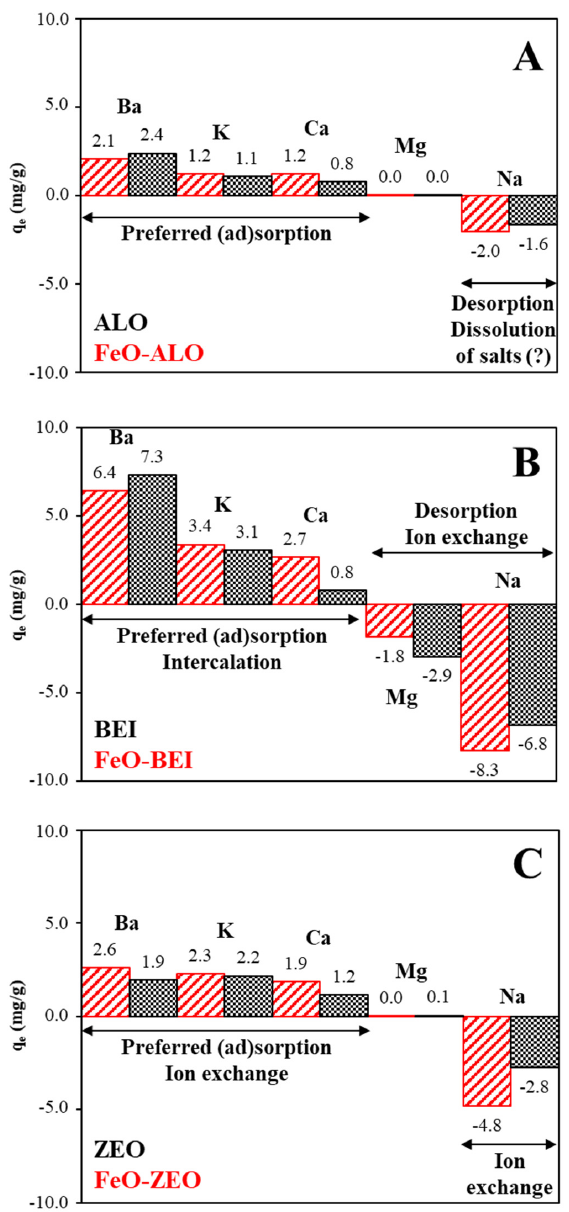
Figure 8. Effect of competing ions (operational conditions: 298 K, pH 6.0, adsorbate/adsorbent ratio: 500:1, cations: 0.85 mmol/L Ca 2+ , 0.20 mmol/L Mg 2+ , 163.2 mol/L Na + , 0.38 mmol/L K + and 0.30 mmol/L Ba 2+ ) on the adsorption of natural and FeO-modified ALO ( A ), BEI ( B ) and ZEO ( C ).